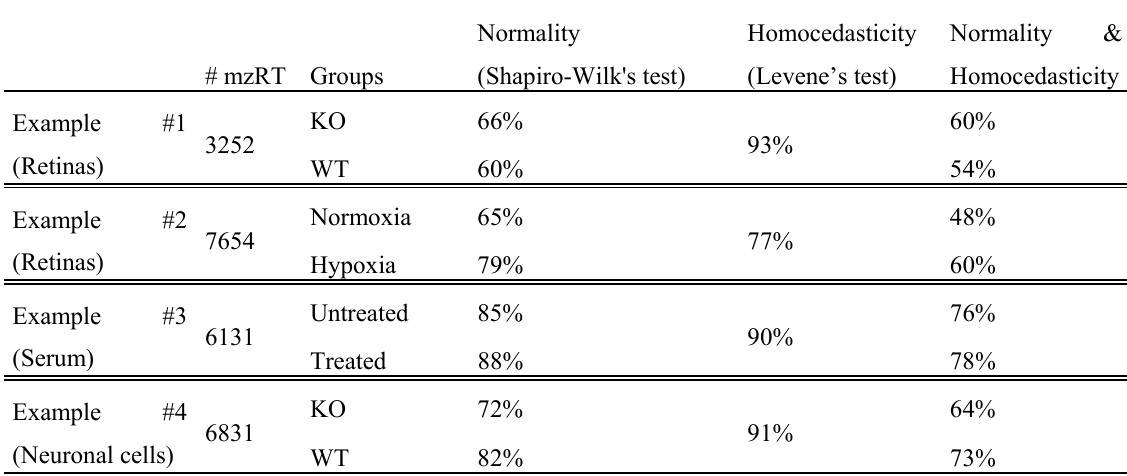
Table 3. mzRT features percentages in which normality, homocedasticity or both assumptions are met. H (Shapiro-Wilk’s test)= Data are sampled from a Gaussian 0 distribution. H (Levene’s test)=Variances are equal. Percentages represent those features 0 in which there were not enough evidences to reject H at conventional  =0.05 relative 0